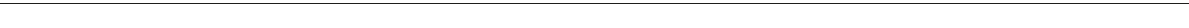
Fig. 1 Generation of ARID1A-knockout (KO) HCT116 cells and screening of epigenetic drug library for synthetic lethality. a Illustration for sgRNA target sites on ARID1A exon 2 for HDR donor plasmid insertion and primers designed for Sanger sequencing. b PCR ampli fi cation of ARID1A exon 2 using the designed primers in HCT116 ARID1A + / + and three ARID1A − / − clones. ARID1A − / − clones #1 and #2 are homozygous ARID1A-KO with HDR donor plasmid insertion into ARID1A gene. Clone #3 is a heterozygous ARID1A − / − containing a HDR insertion mutation and an NHEJ Indel mutation. c Immunoblot analysis showing loss of ARID1A expression in the three ARID1A − / − clones. d Schematic illustration of the synthetic lethality epigenetic drug screening. HCT116 ARID1A + / + and ARID1A − / − #1 cell lines were screened in parallel with 128 epigenetic drug library in an 8-dose titration format. After incubation with the drug library for 72 h, cell viability was determined by AlamarBlue assay. e A log10-IC 50 plot of the screening results. A log10 scale of IC 50 values of the drugs against HCT116 ARID1A + / + and ARID1A − / − cells was plotted. Drugs with selectivity index (SI) > 2 for ARID1A − / − cells were selected and marked as synthetic lethality candidates. f Dose – response curves of HCT116 ARID1A + / + and three ARID1A − / − clones treated with Aurora A inhibitor I (AURKAi) for 72 h are shown. Error bars represent s.d. ( n = 9) from three independent experiments. Survival curve of all three KO clones versus wild-type cells P value < 0.0001, ANOVA. g – k Dose – response curves of HCT116 ARID1A isogenic cell pair treated with AURKAi ( g ) and known synthetic lethality compounds for ARID1A, including tubastatin A (HDAC6 inhibitor) ( h ), VE-821 (ATR inhibitor) ( i ), olaparib (PARP inhibitor) ( j ), and EPZ-6438 (EZH2 inhibitor) ( k ), are shown. HCT116 ARID1A + / + and ARID1A − / − #1 clone were incubated with indicated compounds for 72 h and the cell viability was determined by AlamarBlue assay. Error bars represent s.d. ( n = 9) from three independent experiments. ANOVA P value of <0.0001 for AURKAi, tubastatin A, VE-821, and olaparib. ANOVA P value of 0.1629 for